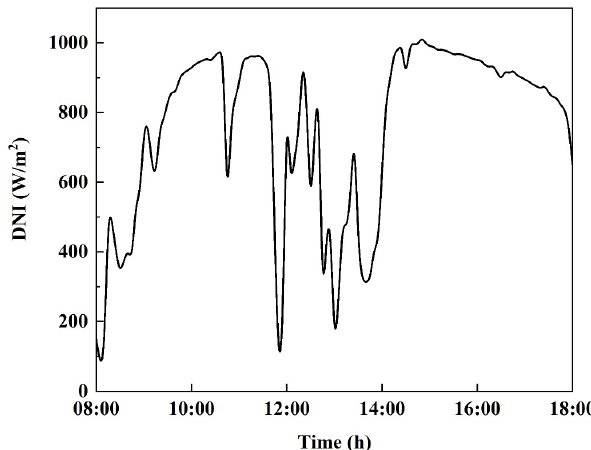
Figure 4. DNI on the vernal equinox. The figures indicate that the energy flux distribution on the surface of the tube panel was very uneven. The energy flux of a single tube panel was high in the middle and low on both sides; that is, the position of the entrance and exit of the tube panel was low and the position of the middle was high. The energy flux density on a single tube panel was in a Gaussian distribution. This distribution mode was influenced by the central point focusing mode adopted in the heliostat field. The variation of the DNI had a direct effect on the total energy absorbed by the receiver, and the energy flux on the surface of the receiver had a positive correlation with the DNI. Moreover, the maximum energy flux at each specific time appeared in sequence on the W1 to W4 panels. Over time, the highest point moved toward the tube panel behind the flow path. The energy flux on the surface of the last four tube panels (from W5 to W8) decreased in